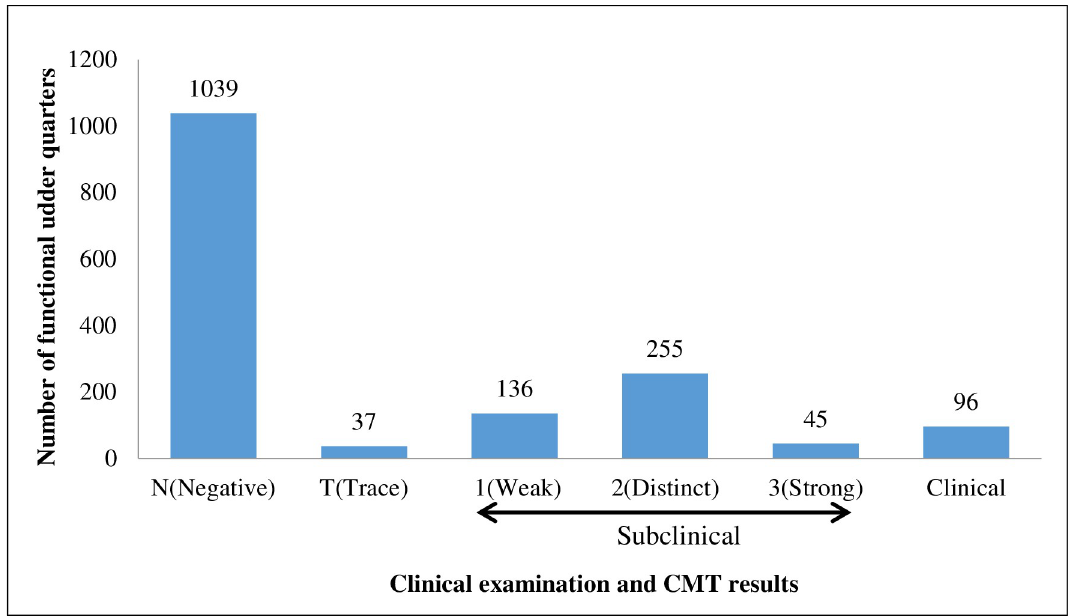
Fig 2. Clinical examination and CMT results for functional